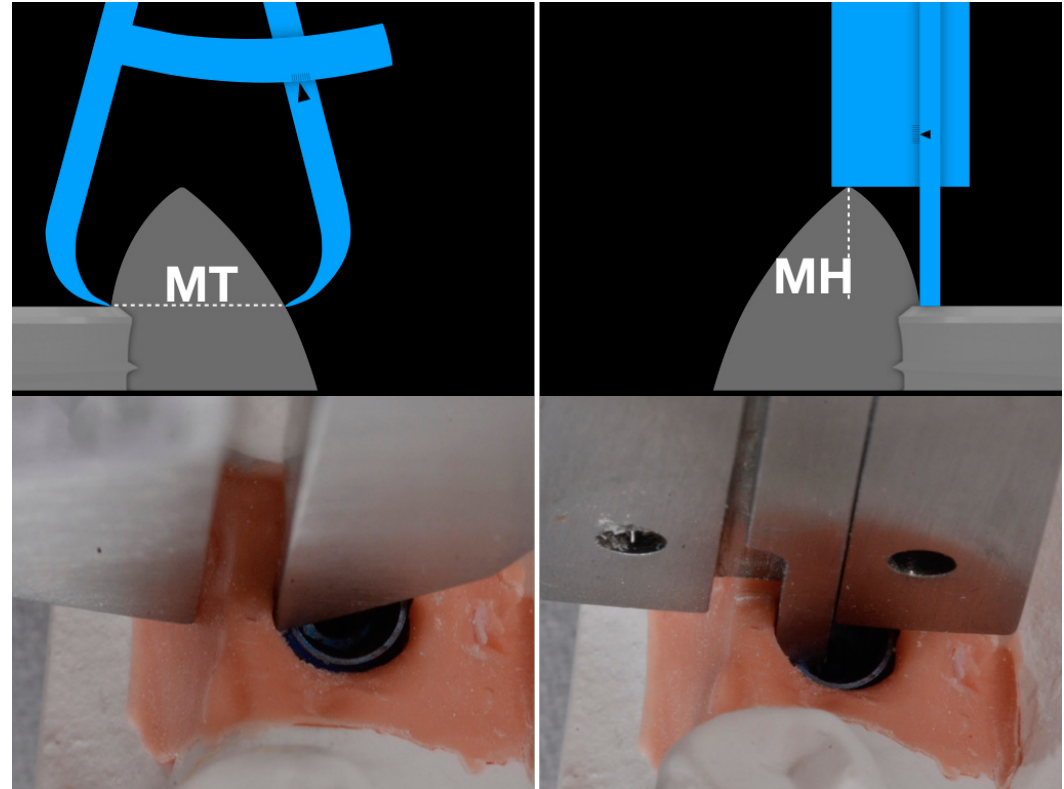
Figure 2. The height of the peri-implant mucosa (MH), calculated from the vestibular shoulder of the implant analogue to the upper gingival margin of the supra-implant tissue according to the implant major axis. The width of tissue (MT) at the connection level is calculated from the vestibular shoulder of the analogue to the external mucosa point perpendicular to the implant major axis. The measurements are taken over the buccal zenith parabola.